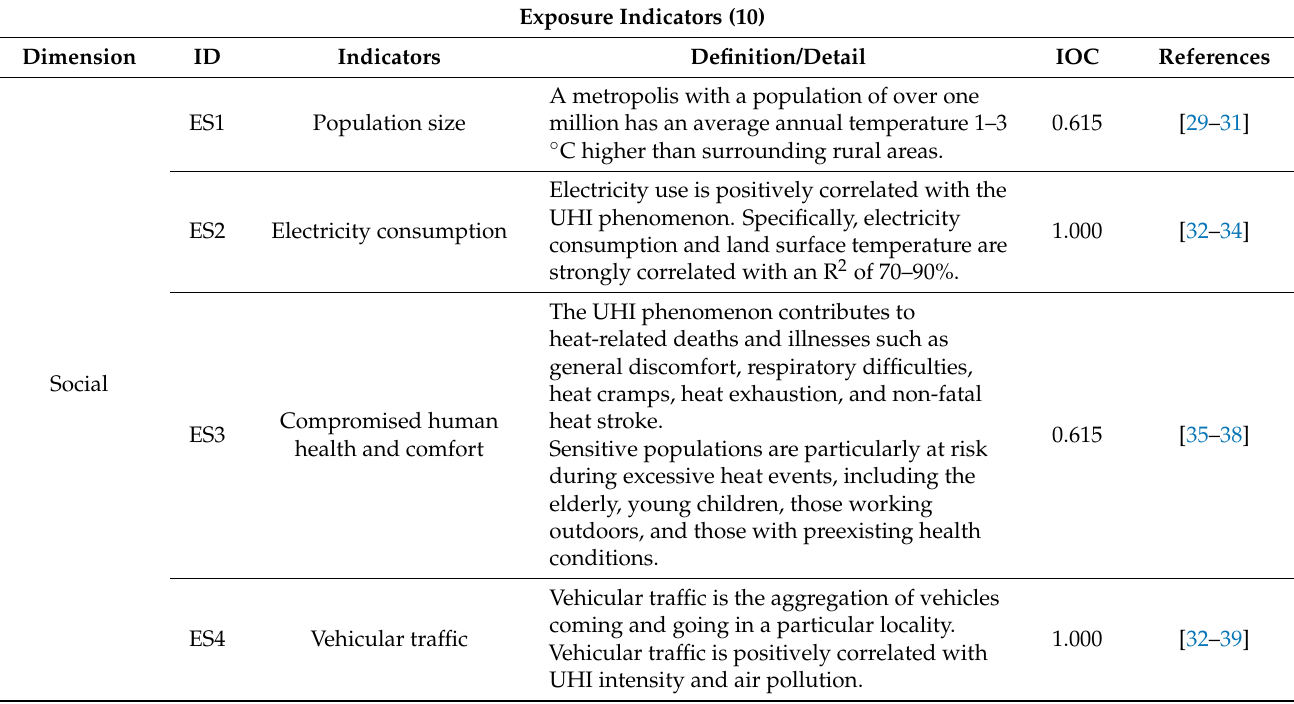
Table 2. The UHI exposure indicators, definitions and expert-validated IOC